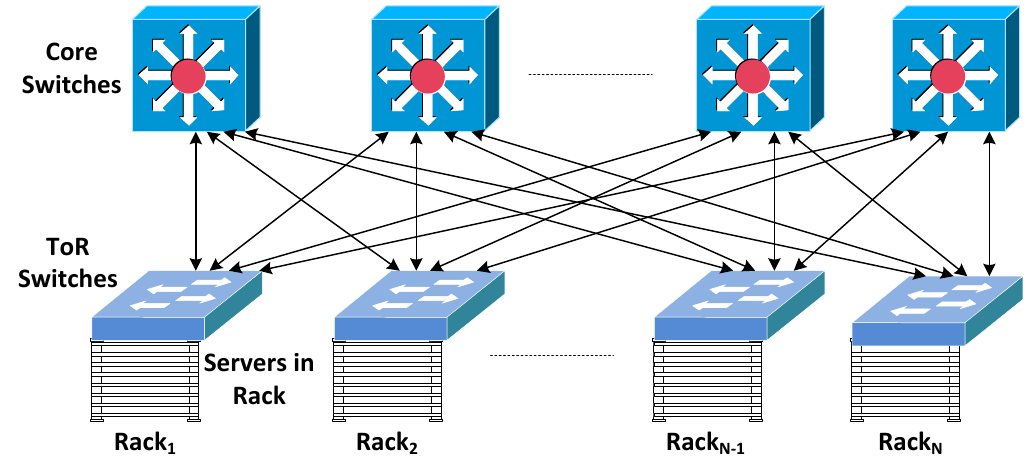
Figure 3. Topology diagram for the baseline electrical network (Leaf-spine topology).